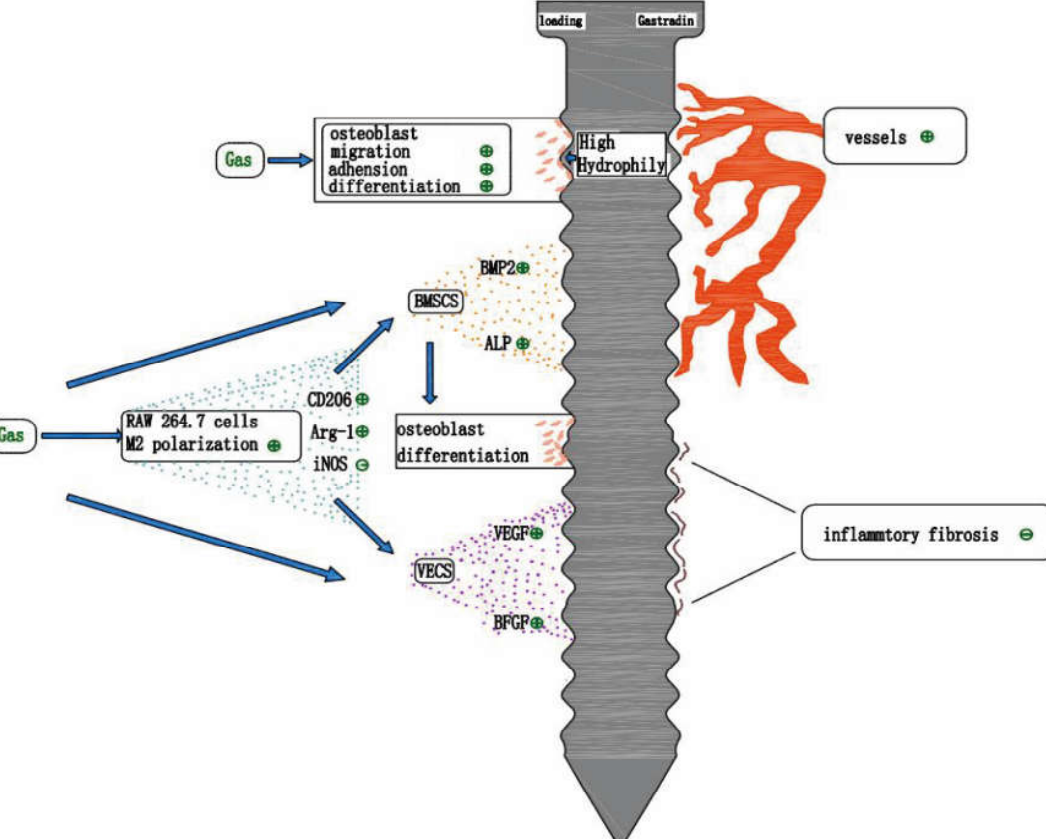
Figure 6. The potential effects of using gastrodin in oral implant surface loading. Gastrodin improves the implant surface hydrophilicity, which is beneficial to cells adhesion. Sustained-release gastrodin promotes the differentiation and migration of osteoblasts. Gastrodin-induced macrophage M2 polarization drives osteogenic differentiation of BMSCs and vascular regeneration, and reduces the production of inflammatory fibers. Finally, the osseointegration process is accelerated.